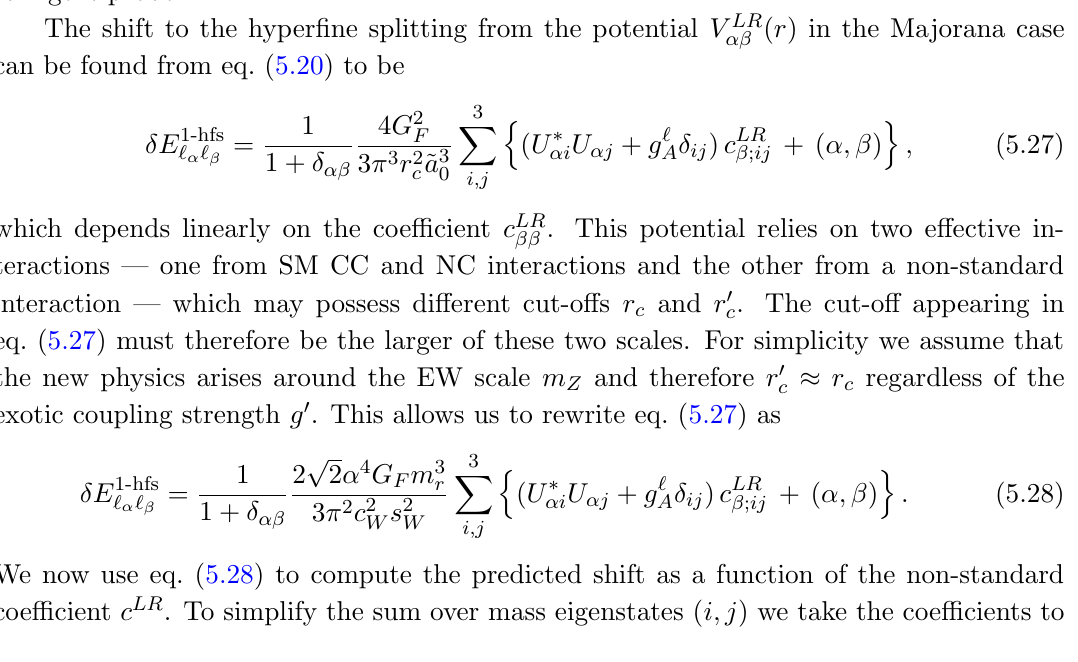
neutrino-exchange (cid:14)E n (cid:0) hfs (cid:11)(cid:12) the experiment-theory di(cid:11)erence. The hyper(cid:12)ne splitting of muonium is therefore the most stringent